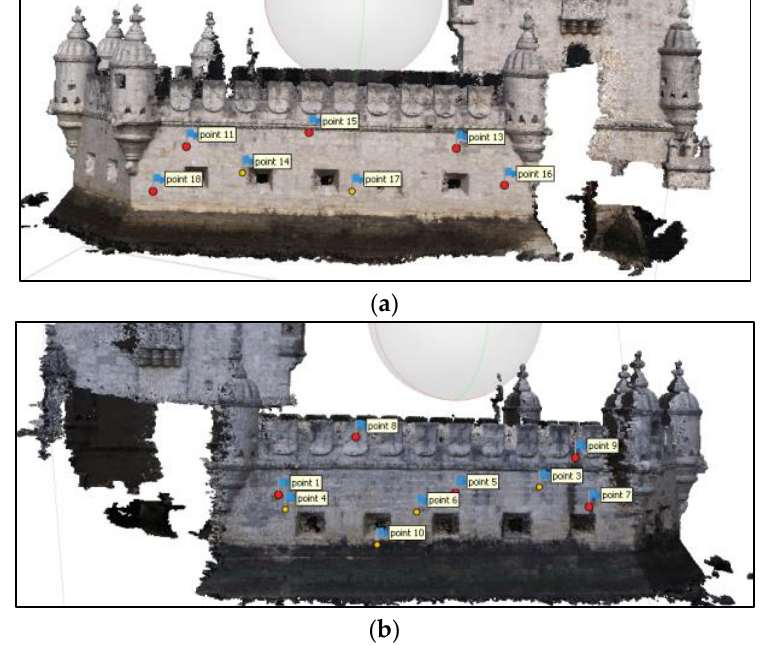
Figure 14. Silica distribution of control (red) and check (yellow) points for georreferencing the photogrammetric point cloud. ( a ) East side; ( b ) West side.